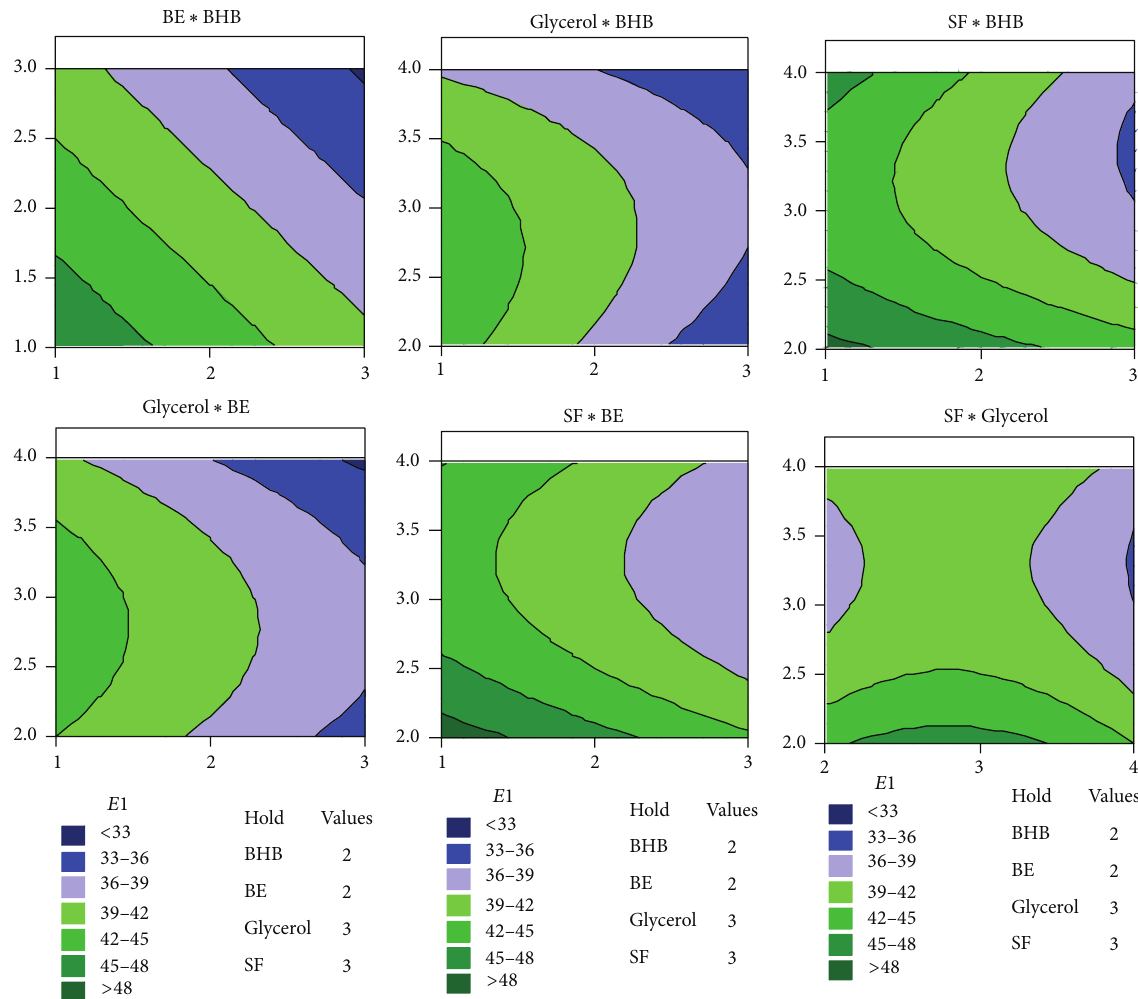
Figure 4: Contour plots for the